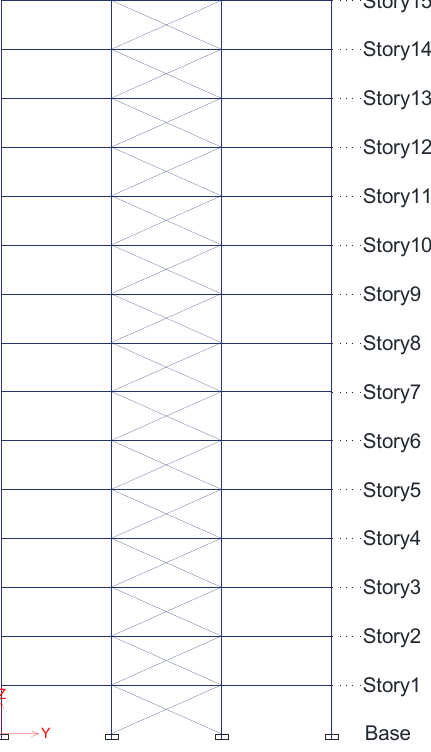
Figure 2. 15 Story building frame in the Etabs software.